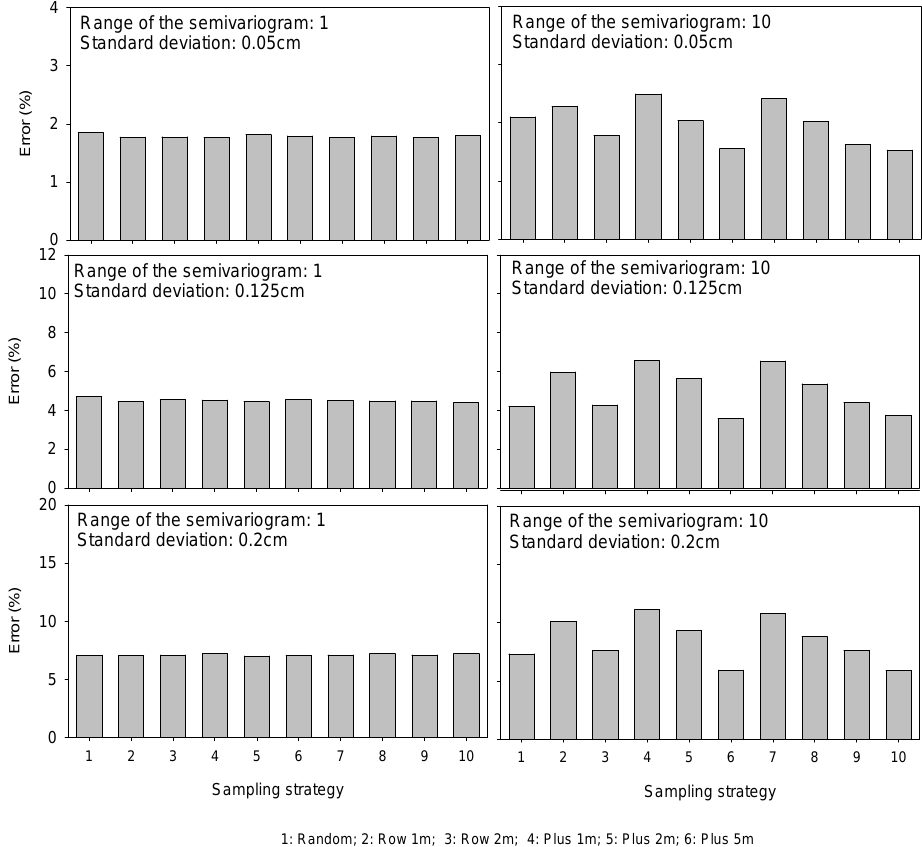
Figure 9 3 Fig. 9. Impact of sampling strategy on error estimation at the plot